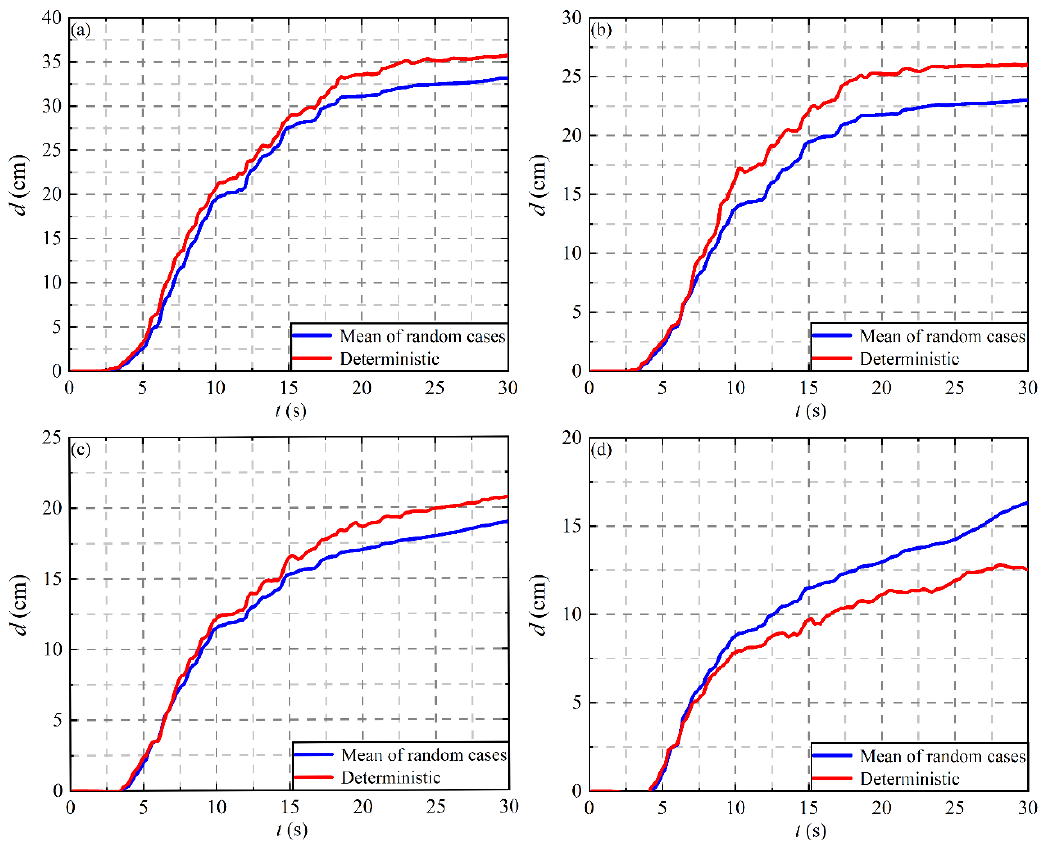
Table 3. Comparison of maximum vertical displacement between surface and tunnel.